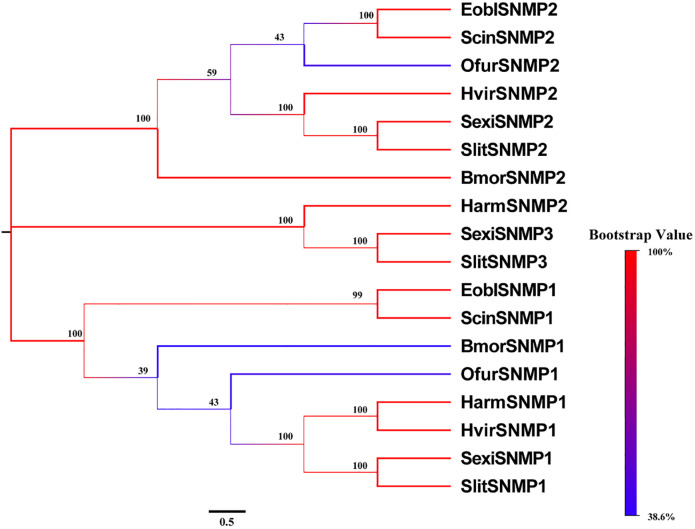
Phylogenetic tree of SNMP proteins in Semiothisa cinerearia, Ectropis obliqua, Spodoptera exigua, Spodoptera litura, Bombyx mori, Ostrinia furnacalis, Helicoverpa armigera and Heliothis virescens.The sequences used in this analysis are listed in S6 Table.